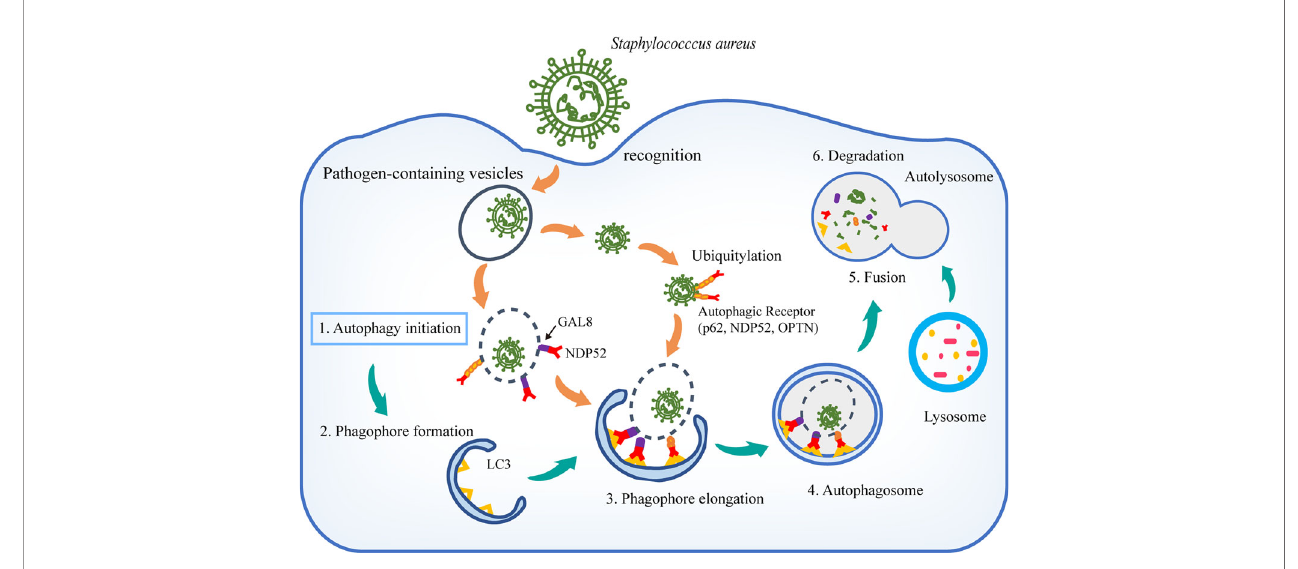
FIGURE 1 | Host autophagy in defense against S. aureus . The components of S. aureus are detected as PAMPs by host PRRs, and autophagy is induced. Autophagy receptors p62, NDP52, and OPTN function as bridging adaptors to induce selective autophagic degradation of invading pathogens by speci fi cally recognizing ubiquitin-coated intracellular pathogens. Damaged pathogen-containing vesicles are detected by GAL8. GAL8 monitors endosomal integrity and activates antibacterial autophagy in conjunction with the autophagy receptor NDP52. During autophagy, LC3 is recruited to autophagosomal membranes. Autophagosome subsequently fuses with a lysosome to form the autolysosome, where the acidic environment and enzymes mediate the bacterial